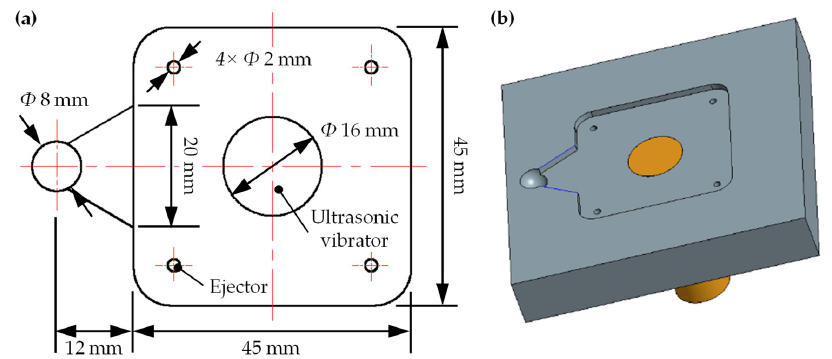
Figure 1. The gate and the cavity. ( a ) Planar dimensions and ( b ) three-dimensional model (including the upper part of the ultrasonic vibrator).